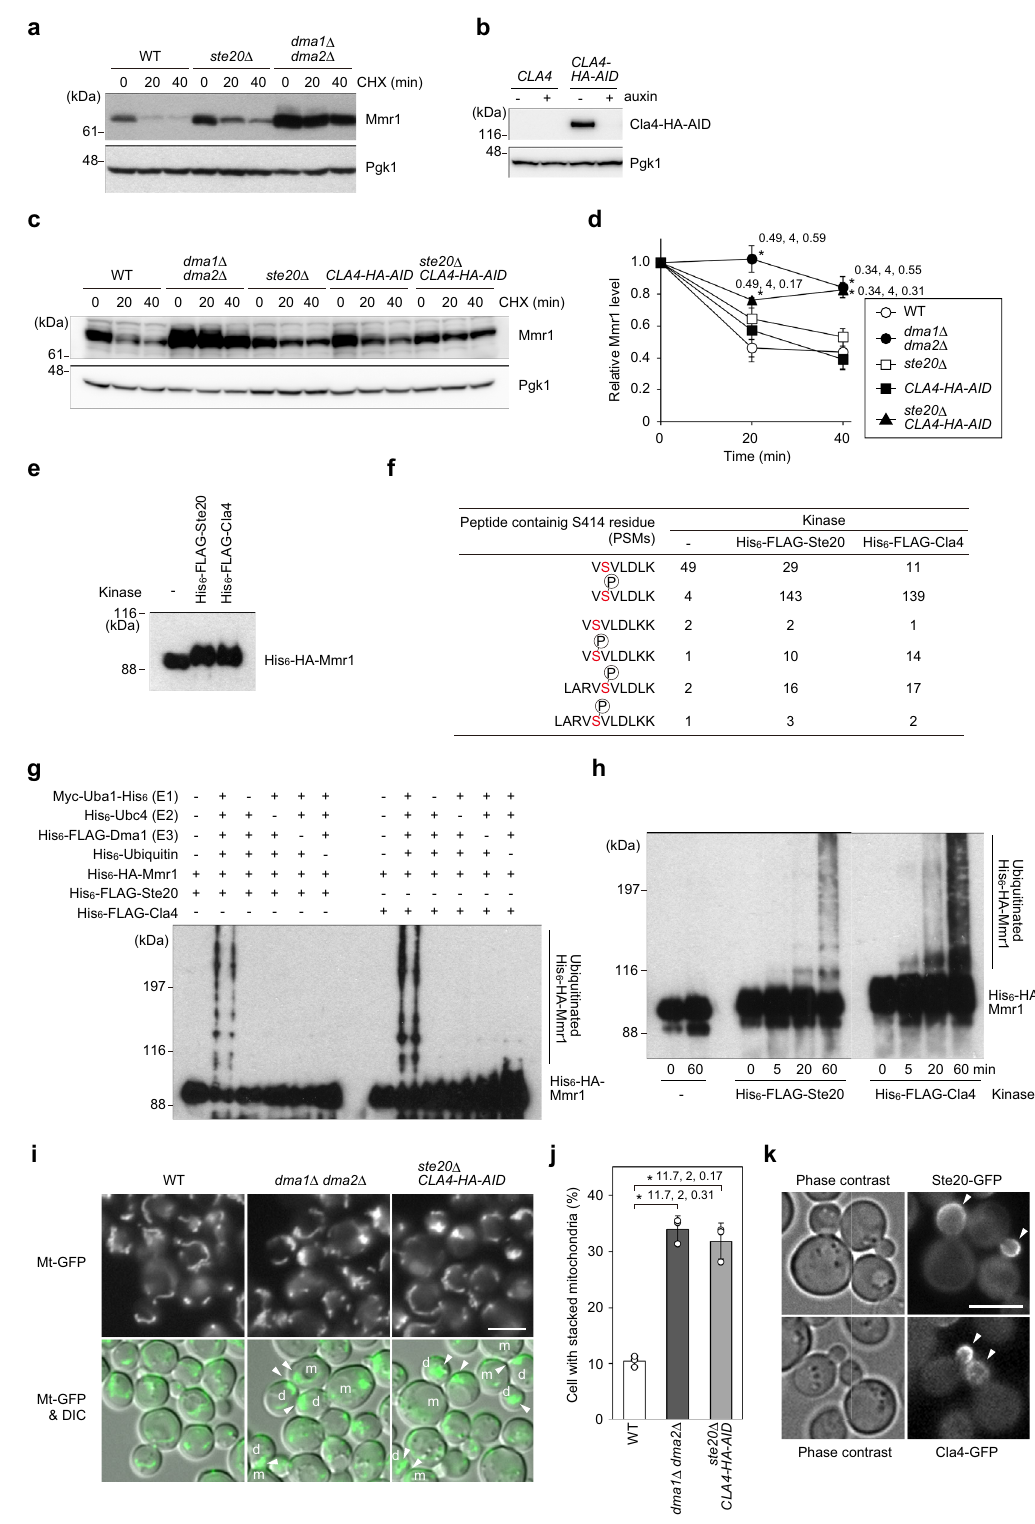
adding puri fi ed E1 (Myc-Uba1-His 6 ), E2 (His 6 -Ubc4), E3 (His 6 - FLAG-Dma1), and ubiquitin (His 6 -ubiquitin). In this recon- stitution system, puri fi ed His 6 -HA-Mmr1 was ubiquitinated depending on E1, E2, E3, ubiquitin, and pretreatment with either His 6 -FLAG-Ste20 or His 6 -FLAG-Cla4 (Fig. 5g, h), indicating the critical role of Ste20 and Cla4 in Dma1/2-mediated Mmr1 ubi- quitination. Next, we analyzed the dynamics of mitochondria in NATURE COMMUNICATIONS| (2022) 13:2005